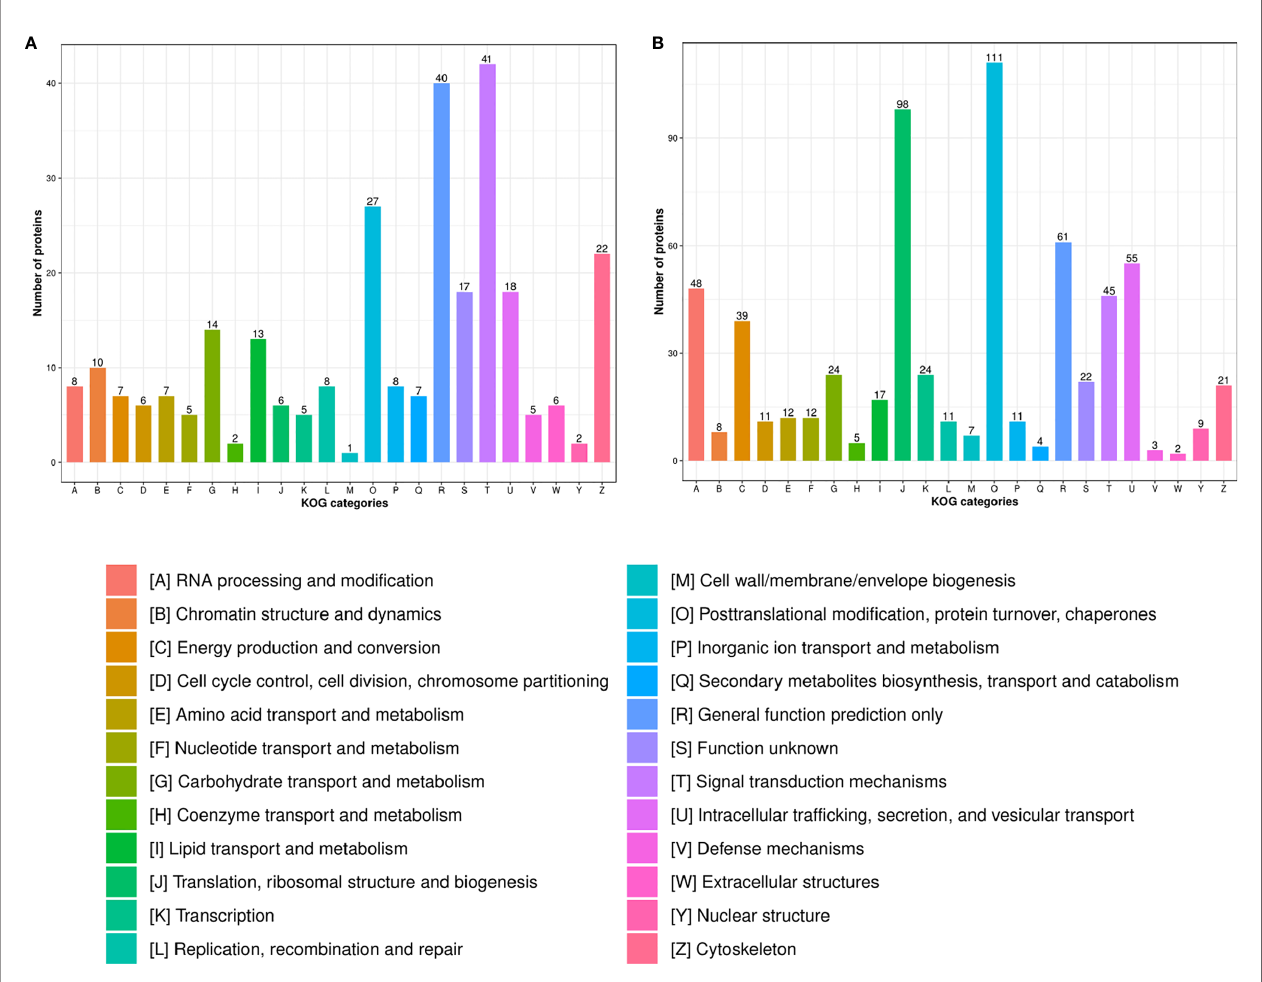
FIGURE 3 | COG analysis of DEPs in the (A) HT vs . H and (B) HT vs . T groups. X-axis represents COG/KOG categories. Y-axis represents the numbers of